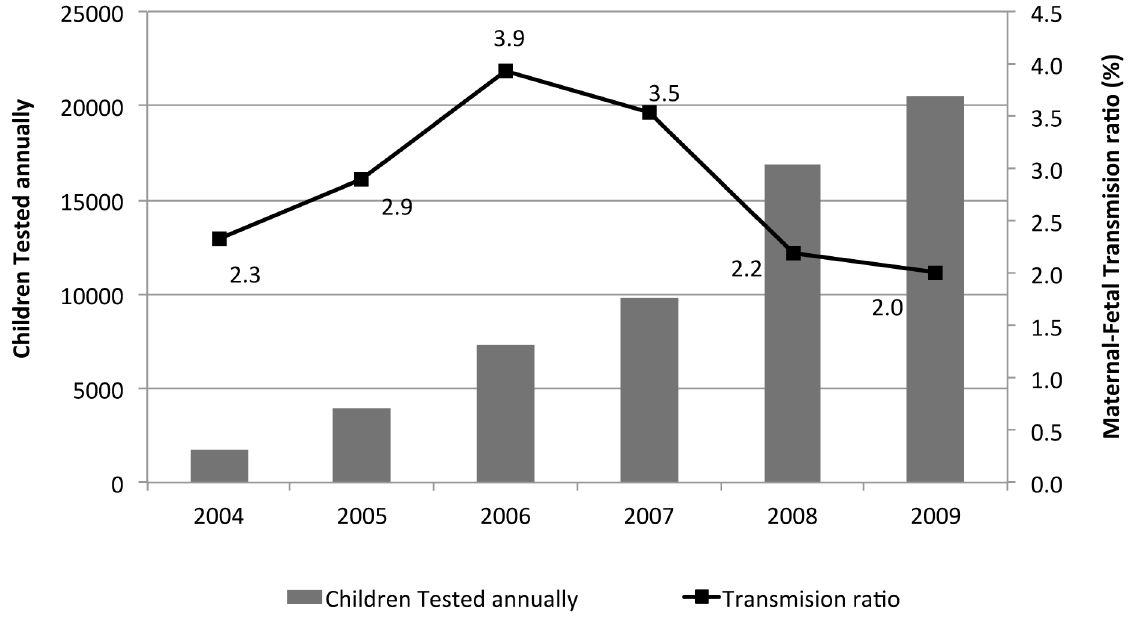
Figure 5. Maternal - Fetal transmission ratio and controls carried out on children less than one year of age born from positive mothers. The Maternal-Fetal transmission ratio is calculated with the total number of congenital Chagas cases per year, over the number of children born from positive mothers tested at birth. The ratio decreases as the number of annually tested children increases.